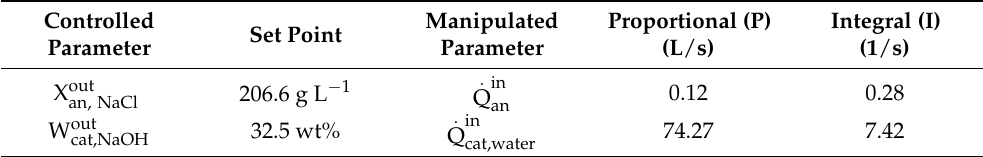
Table 2. Pairing and parameterization of the implemented controllers.